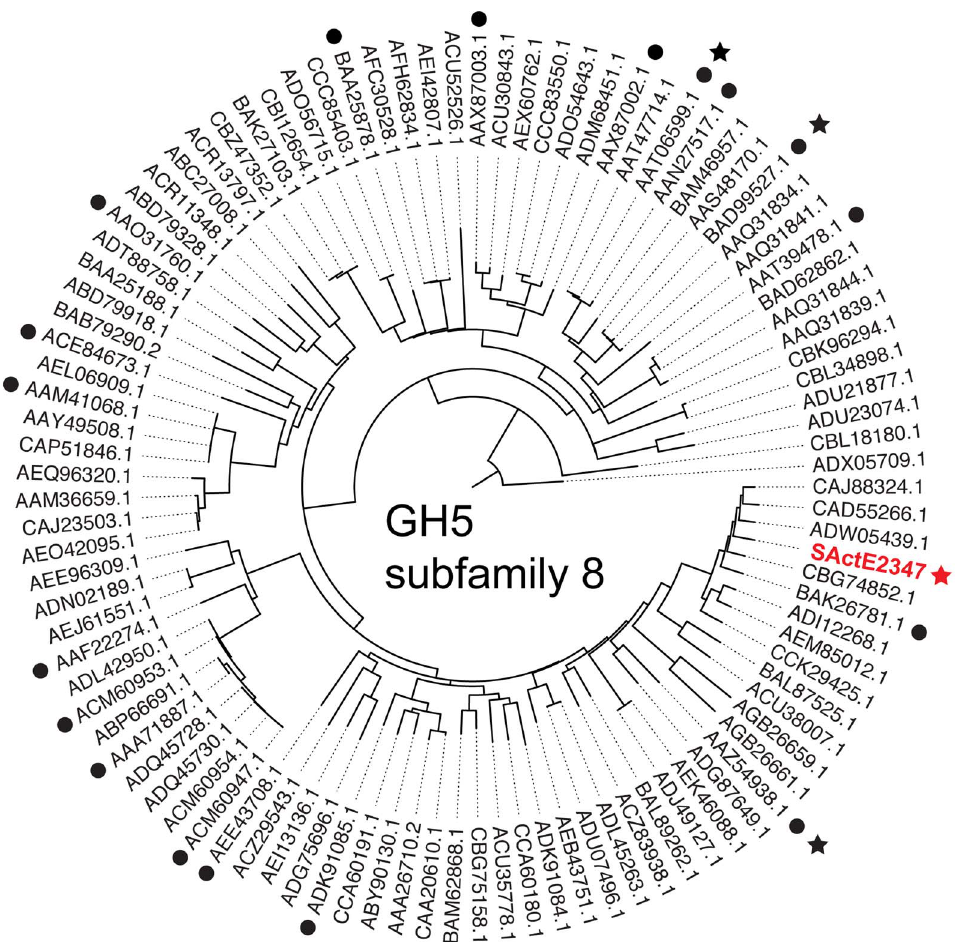
Figure 1. Phylogeny of GH5 subfamily 8 including SACTE_2347. The phylogenic tree was constructed from all sequences assigned to the GH5 subfamily 8. Names shown are GenBank accession codes. Black circles indicate enzymes that have been experimentally verified to exhibit b - mannanase activity; black stars indicate three enzymes whose structures have been determined besides SACTE_2347. These are: Thermomonospora fusca , AAZ54938.1, PDB 1BQC, 2MAN, 3MAN; Bacillus sp. N16-5, AAT06599.1, PDB 2WHJ, 2WJL, 3JUG; Bacillus sp. JAMB-602, BAD99527.1, PDB 1WKY.